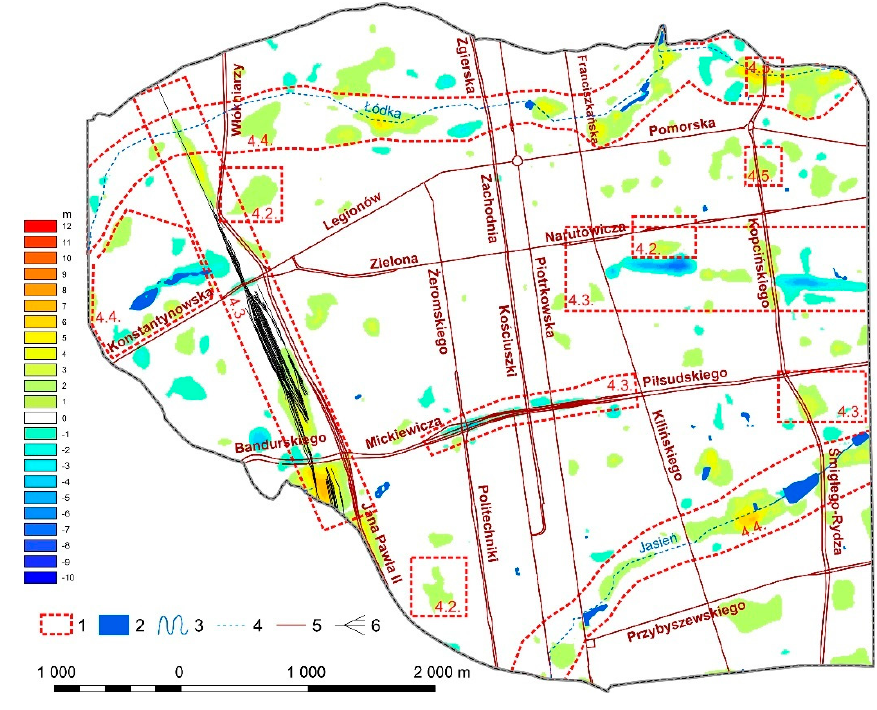
Figure 10. Changes in relief for a fragment of Ł ód ź in 1917–2017 against contemporary elements of the city’s environment and infrastructure. 1—areas of detailed analysis, 2—waters, 3—surface watercourses, 4—underground watercourses, 5—main streets, 6—railway tracks (situation in 2017). Source: Own study.